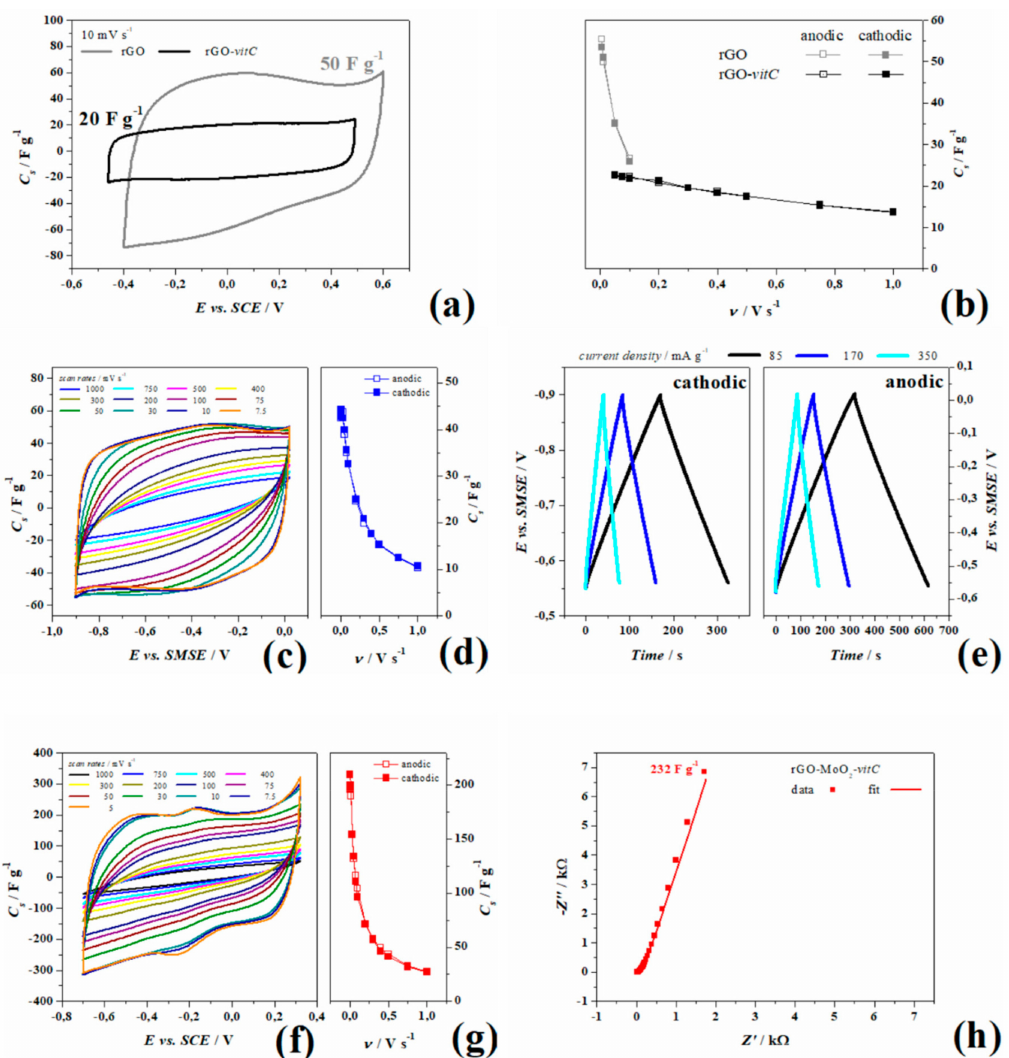
Figure 4. Comparison in 1 M NaCl of pristine rGO (gray) and rGO- vitC (black) in ( a ) cyclic voltammetry at 10 mV s − 1 and ( b ) specific capacitance at multiple scan rates. Experiments carried out 1 M Na 2 SO 4 : ( c ) Cyclic voltammetry, ( d ) specific capacitance at multiple scan rates, and ( e ) galvanostatic charge / discharge cycles of rGO- vitC ; ( f ) cyclic voltammetry, ( g ) specific capacitance at multiple scan rates, and ( h ) Nyquist plot at open circuit potential (OCP) of rGO-MoO 2